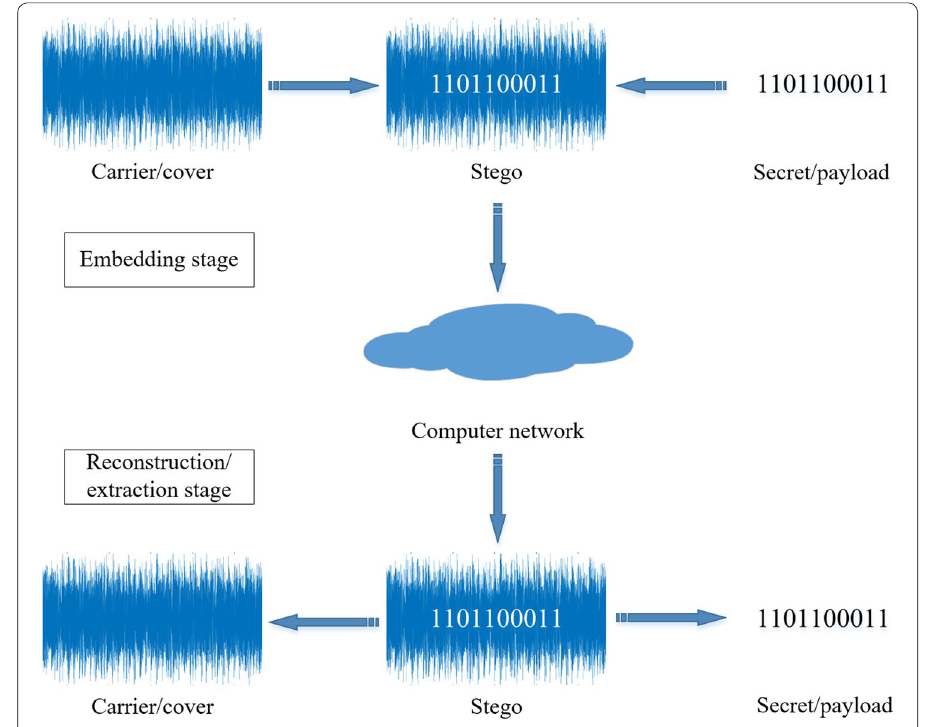
Fig. 1 The overall concept of audio-based data